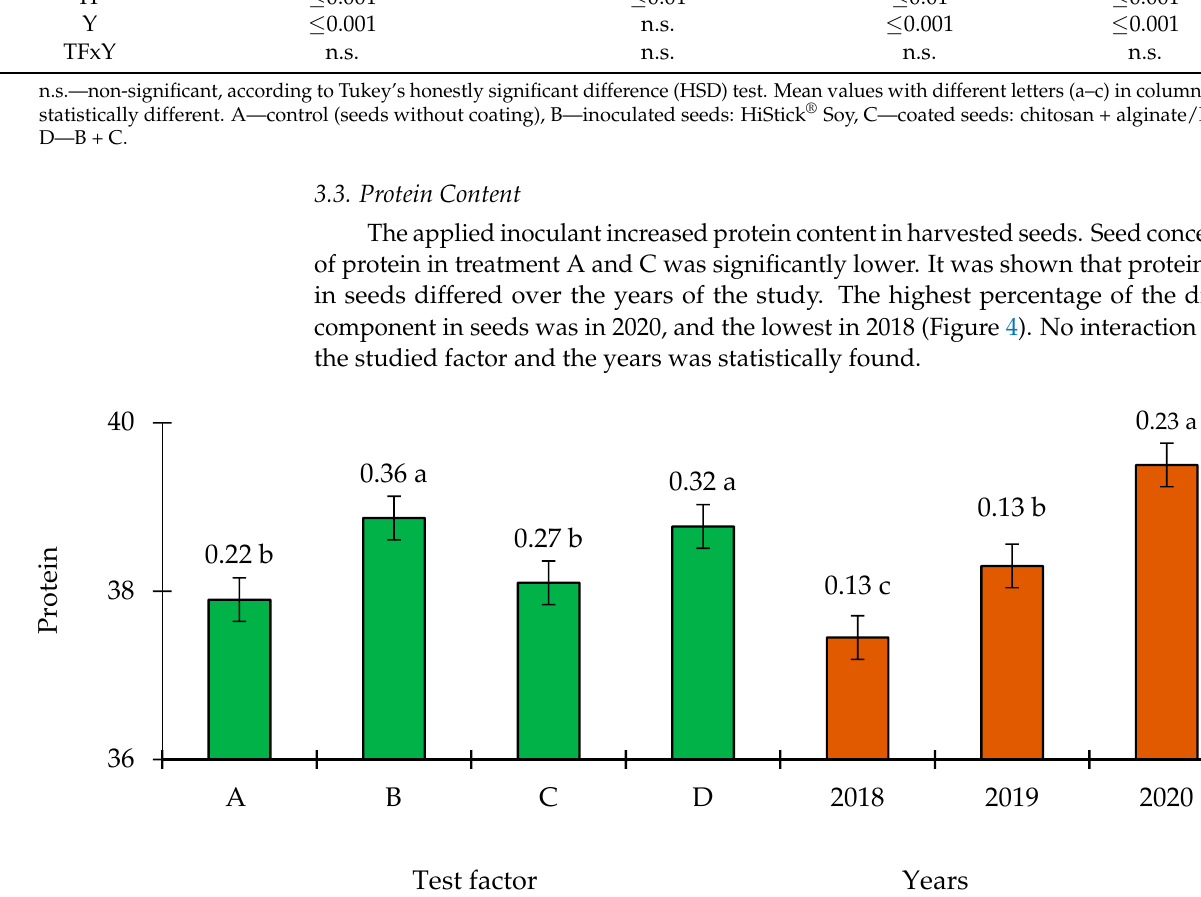
Figure 4. Total protein content (%) in the dry matter of seeds. A—control (seeds without coating), B—inoculated seeds: HiStick ® Soy, C—coated seeds: chitosan + alginate/PEG, D—B + C. Mean values with different letters (a–c) within treatment or year are statistically different at p < 0.001. The numbers on the bars indicate the standard error (SE).